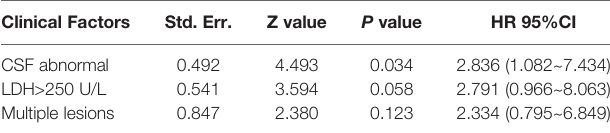
TABLE 5 | Multivariate Cox regression analysis of OS for 38 patients with R/R PCNSL. Clinical Factors Std.